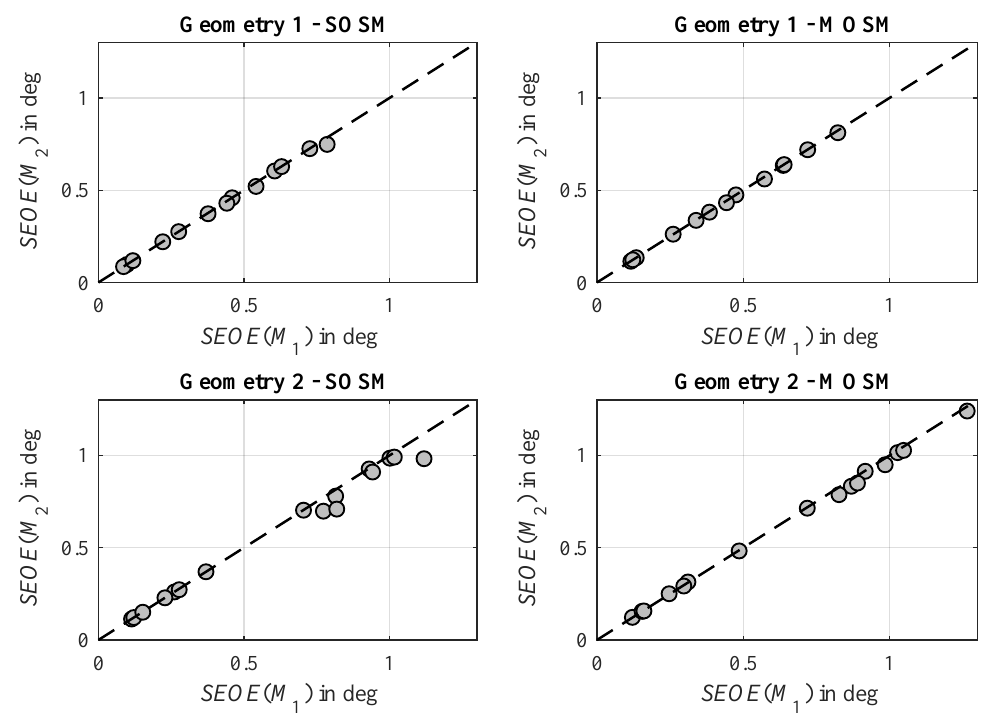
Figure 9. Determined standard error of estimate ( SEOE ) values for the two different model approaches and strategies for all considered operating speeds and the two exemplarily geometries 1 and